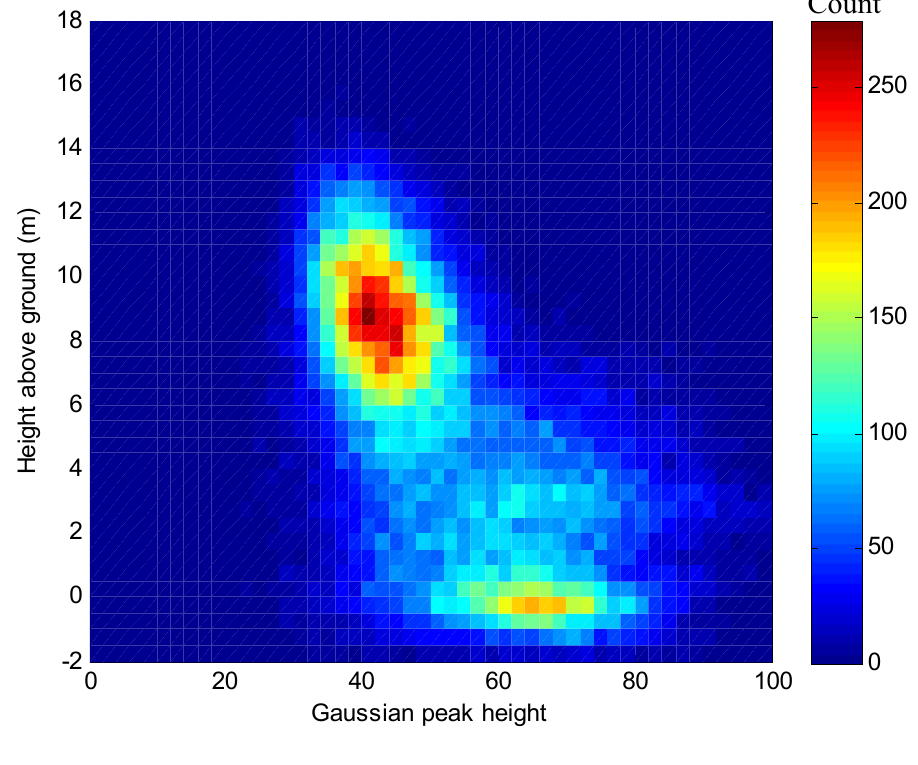
Figure 6. Bivariate frequency distribution of peak height of Gaussian curves fitted to deconvolved waveform LiDAR vs . height above